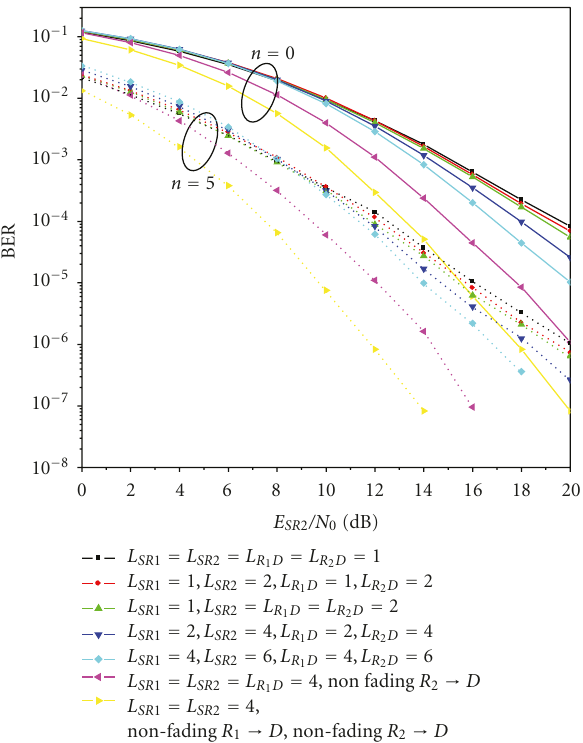
Figure 4: BER performance of DSTBC with di ff erent values of channel memory orders and n -factor over Rician fading